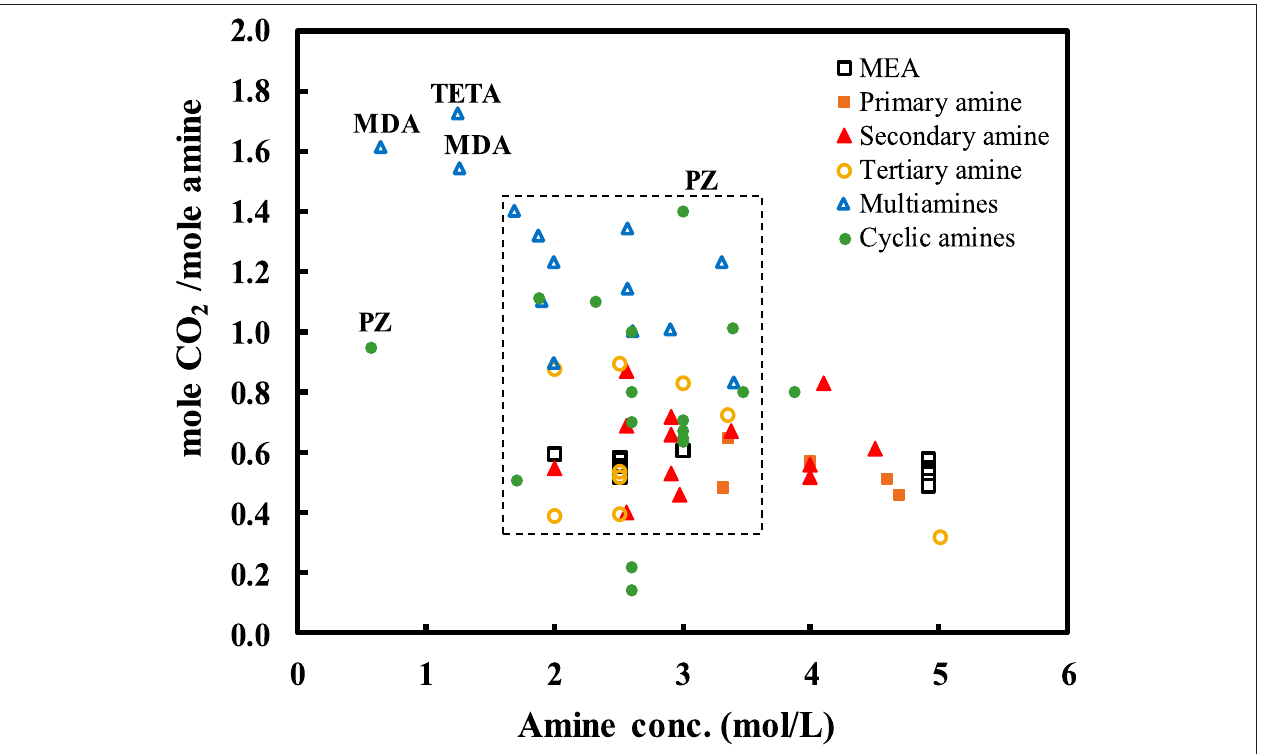
FIGURE 4 | CO 2 uptakes obtained at 40 ° C and CO 2 partial pressure of 15 kPa using different liquid amines with different structures at different amine concentrations. Data from the literature (Shen and Li, 1992; Jou et al., 1995; Park et al., 2002; Benamor and Aroua, 2005; Derks et al., 2005; Maneeintr et al., 2009; Puxty et al., 2009; Chen and Rochelle, 2011; Rebolledo-Morales et al., 2011; Schäffer et al., 2012; Tong et al., 2012; Chang et al., 2013; Monteiro et al., 2013; Yamada et al., 2013; Arshad et al., 2014; Bougie and Iliuta, 2014; Li et al., 2014; Li and Rochelle, 2014; Nouacer et al., 2014; Chen S. et al., 2015; Conway et al., 2015; Mondal et al., 2015; El Hadri et al.,